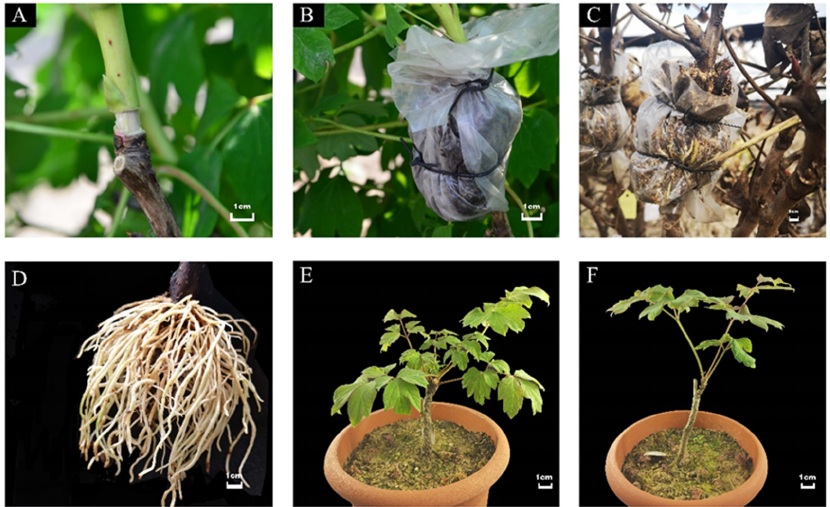
Figure 1. Steps in air layering of tree peony. ( A ) One-centimeter ring-stripping incision. ( B ) Matrix dressing. ( C ) The substrate is covered with new roots. ( D ) The new roots under air layering. ( E , F ) Air-layer growth in pots one year from the air layering.